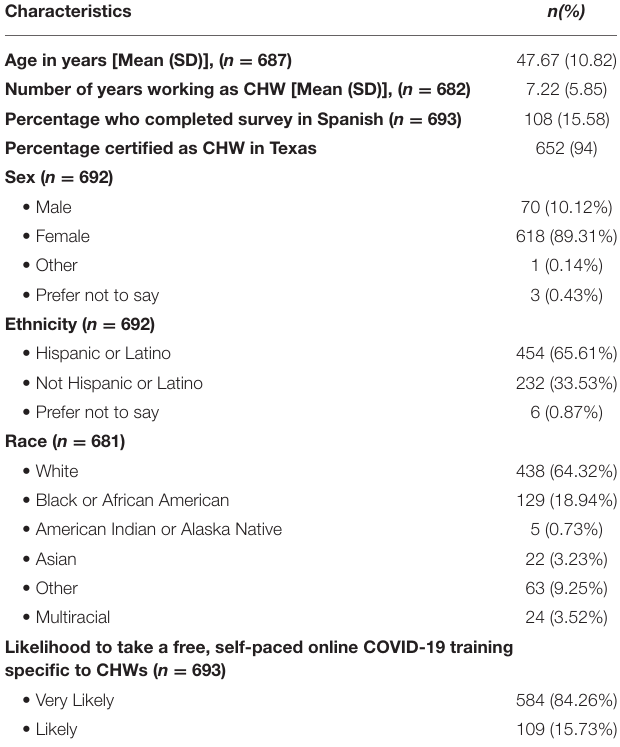
TABLE 1 | Demographic characteristics of Community Health Worker (CHWs) respondents who indicated that they were “Very Likely” or “Likely” to take a free, self-paced online COVID-19 training specific to CHWs and provided a response to the following question: “What topics related to COVID-19 would be most helpful to you as a CHW?” ( n =